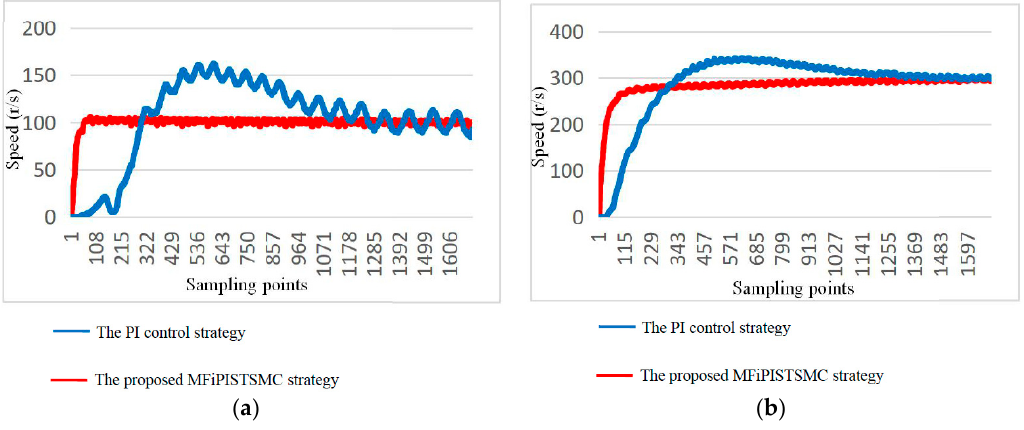
Figure 9. ( a ) The experimental speed response curves starting and stable operation with ω r = 100 r / s using the proposed MFiPISTSMC strategy; ( b ) the experimental speed response curves starting and stable operation with ω r = 300 r / s using the proposed MFiPISTSMC strategy.